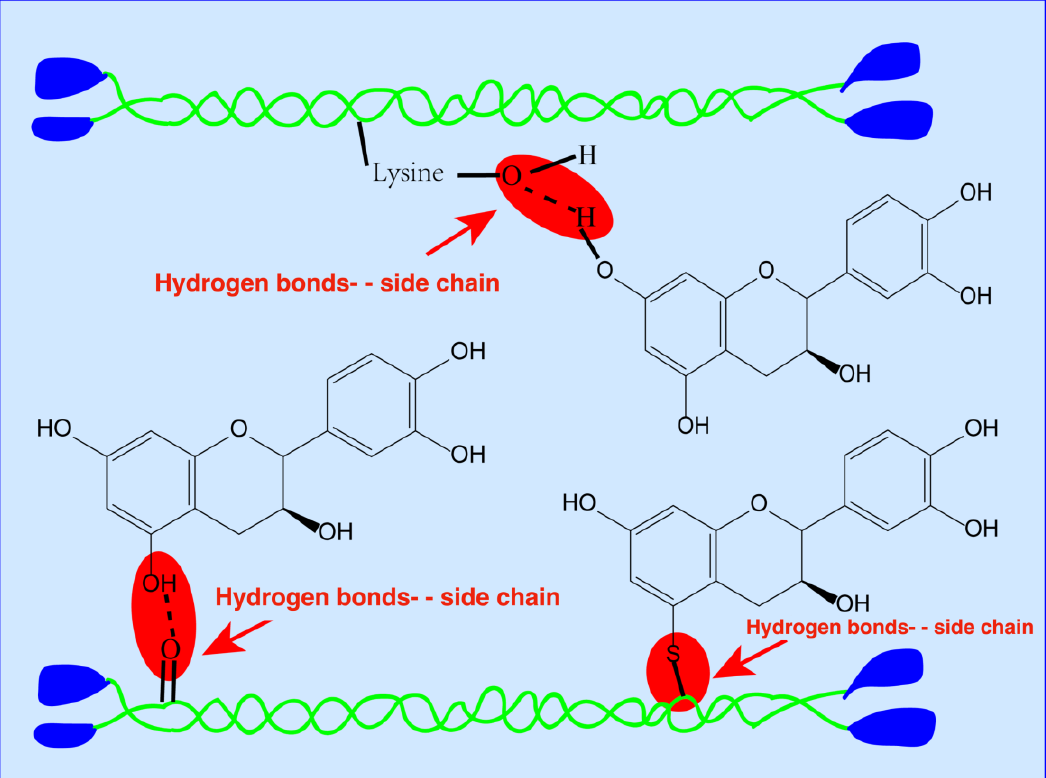
Figure 3. Graphical illustration of cross-linking mechanism between GTE and surimi proteins.